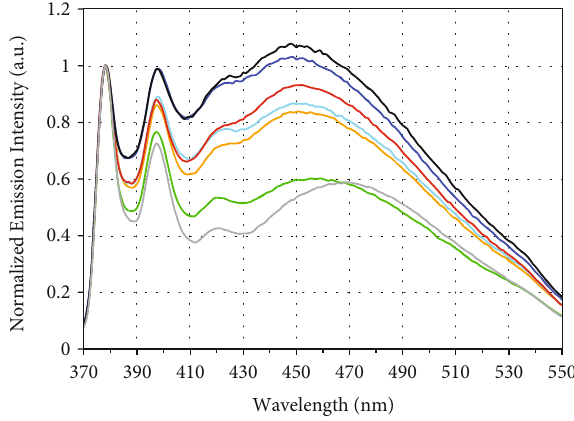
Figure 9: Emission spectra of the Pyr − /LDH fi lm immersed in toluene-ethanol solution (concentration of toluene (v/v) are 0%: black line, 10%: blue line, 30%: red line, 50%: sky-blue line, 70%: orange line, 90%: green line, and 100%: gray